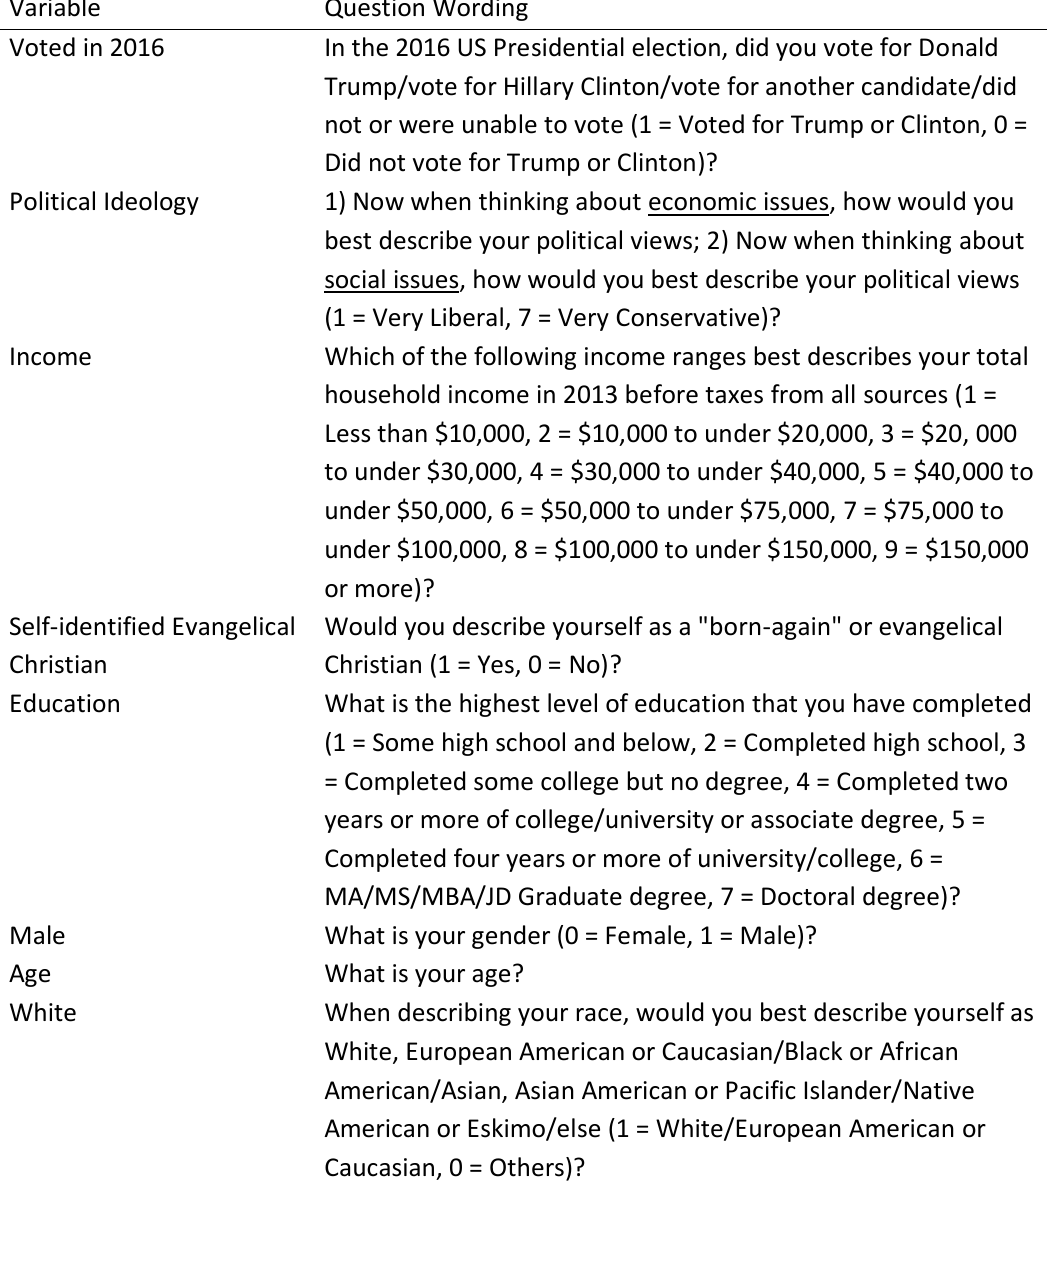
Table A1. Question wording and scales of